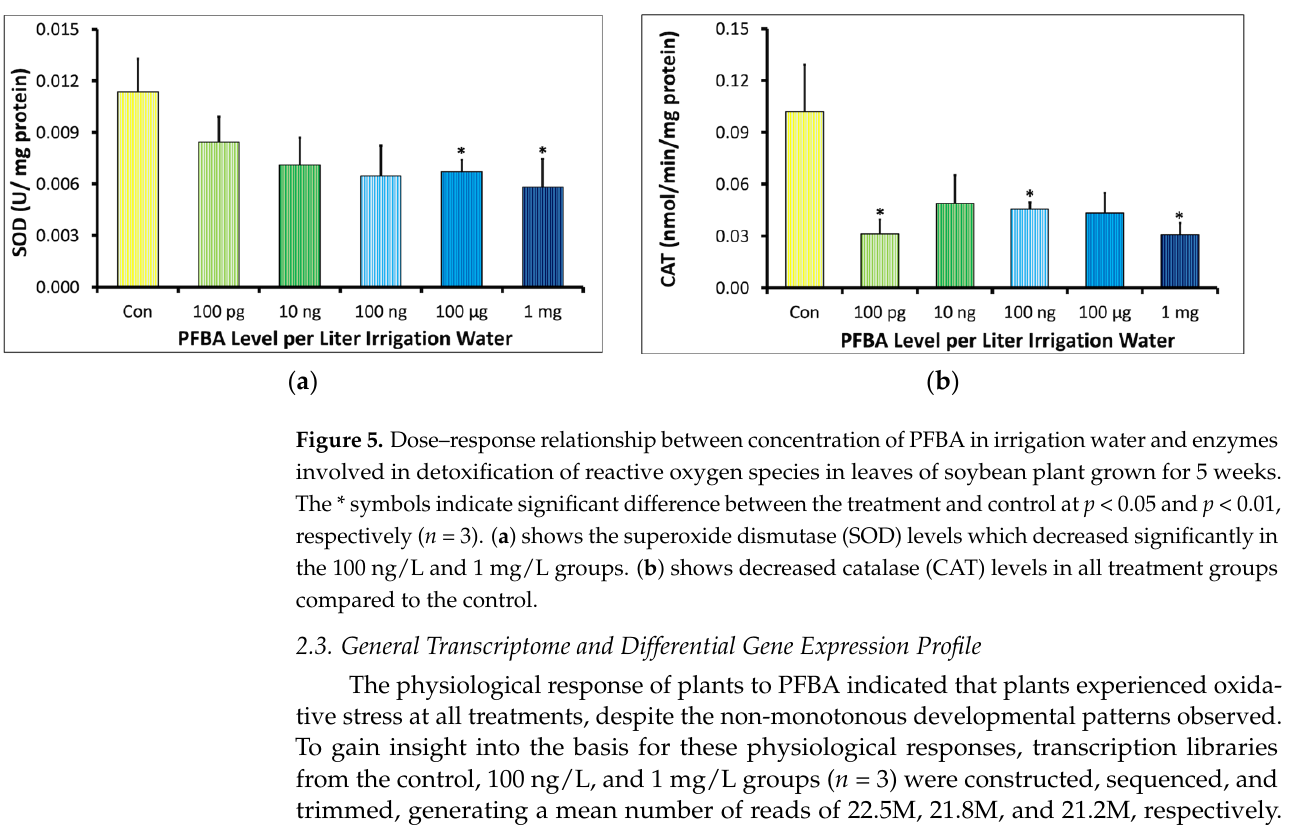
( b ) Figure 4. Dose – response relationship between the concentration of PFBA in irrigation water and reactive oxygen species in leaves of soybean plant grown for 5 weeks. The * and ** symbols indicate significant difference between the treatment and control at p < 0.05 and p < 0.01, respectively ( n = 3).